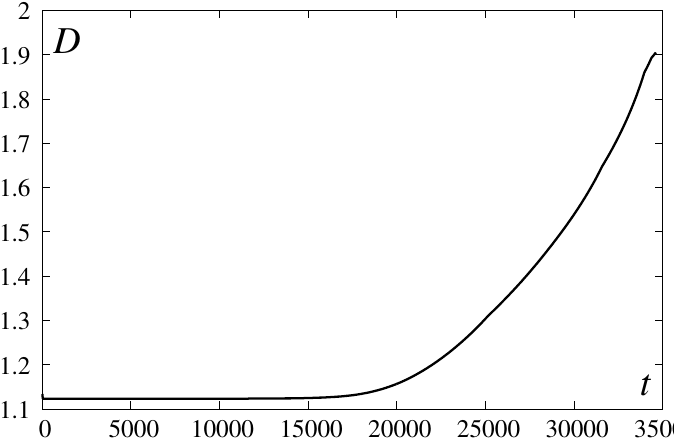
Figure 6. Flame speed D = R t vs. t for the model (11) (12) (16); G = 0.002, κ = 0.1, N = 2 15 .